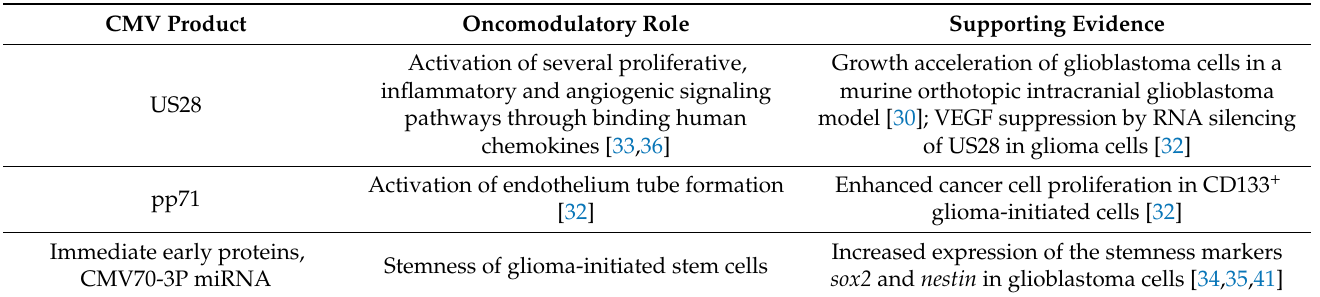
Table 1. The oncomodulatory role of cytomegalovirus (CMV) in malignant brain tumors. CMV Product Oncomodulatory Role Supporting